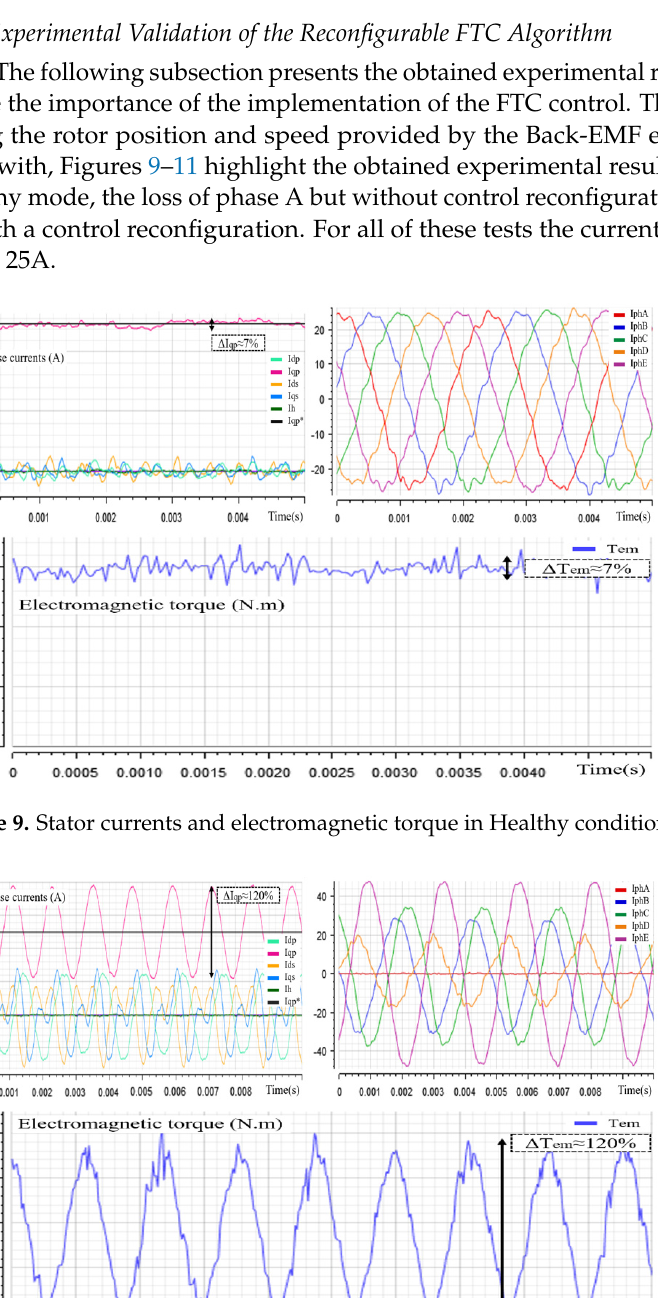
Figure 8. Harmonics minimization mechanism .